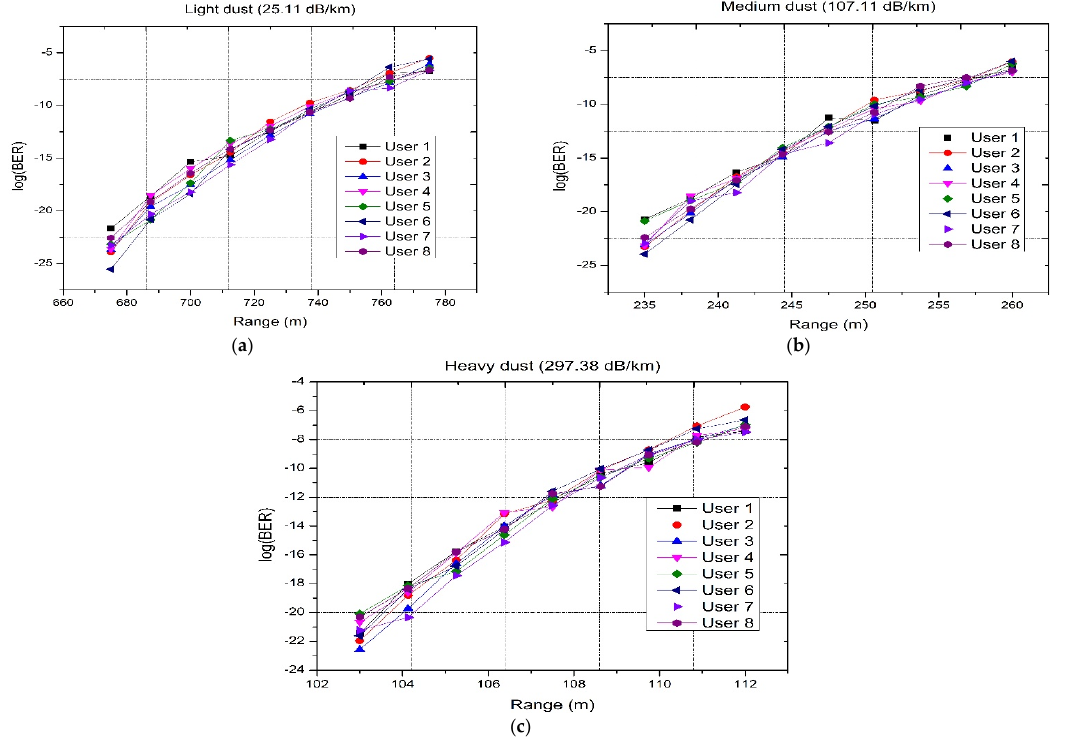
Figure 9. log (BER) of FSO-PDM/PV-OCDMA system versus FSO link under ( a ) LD, ( b ) MD, and ( c ) HD.